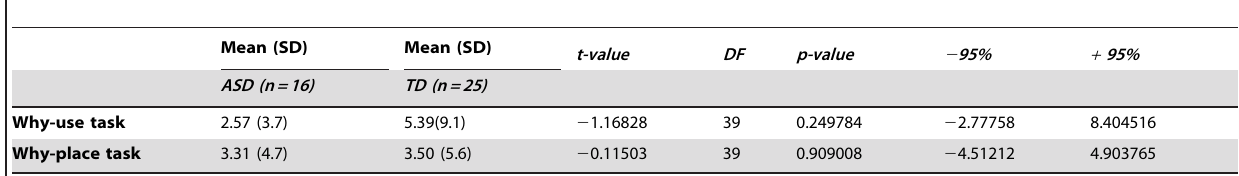
Table 5. Post-hoc comparisons in Experiment 2 between the error rates of the two groups in each of the 3 tasks.